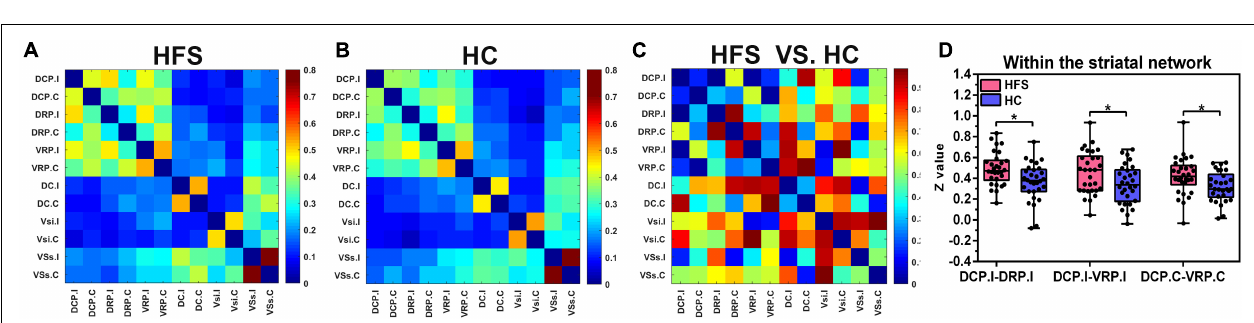
FIGURE 6 | The correlation relationship between spasm severity and altered FC and duration. (A) The FC between contralateral DCP and ipsilateral SFG was negatively correlated with the Cohen spasm scores ( r = − 0.433, P = 0.0168 uncorrected). (B) The FC between ipsilateral VSi and contralateral OFC showed positive correlation with the Cohen spasm scores ( r = 0.6739, P < 0.0001 uncorrected). (C) There was no correlation between the duration and the spasm severity ( r = − 0.2327, P = 0.2158 uncorrected). FC, functional connectivity; DCP, dorsal caudal putamen; SFG, superior frontal gyrus; VSi, inferior ventral striatum; OFC, orbitofrontal cortex.